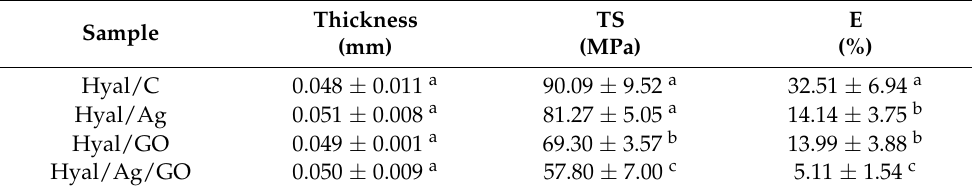
Table 2. Mechanical properties of